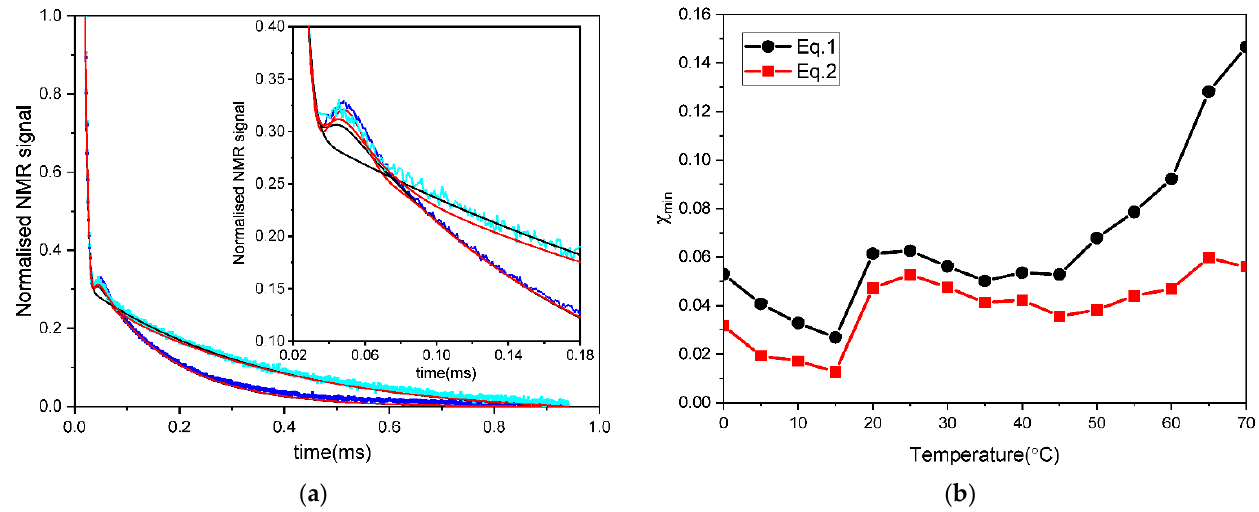
Figure 2. ( a ) The FID signals recorded at 0 ◦ C (blue line and markers) and 70 ◦ C (cyan line and markers) in a rice pasta sample with the water content of 0.1069 g/g d.m. and the fitting curves generated by models described by Equation (1) (solid black line) and Equation (2) (solid red line). ( b ) A plot of χ min resulting from the fitting of the models described by Equation (1) (solid black points and line) and Equation (2) (solid red squares and line) using FABADA for a set of temperatures between 0 ◦ C and 70 ◦ C ( b